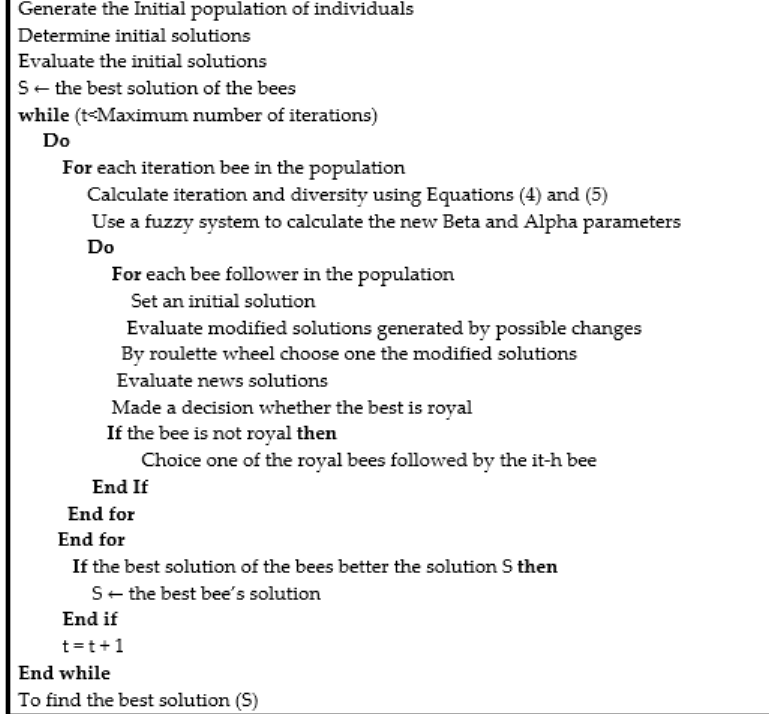
Figure 10. Fuzzy bee colony optimization.